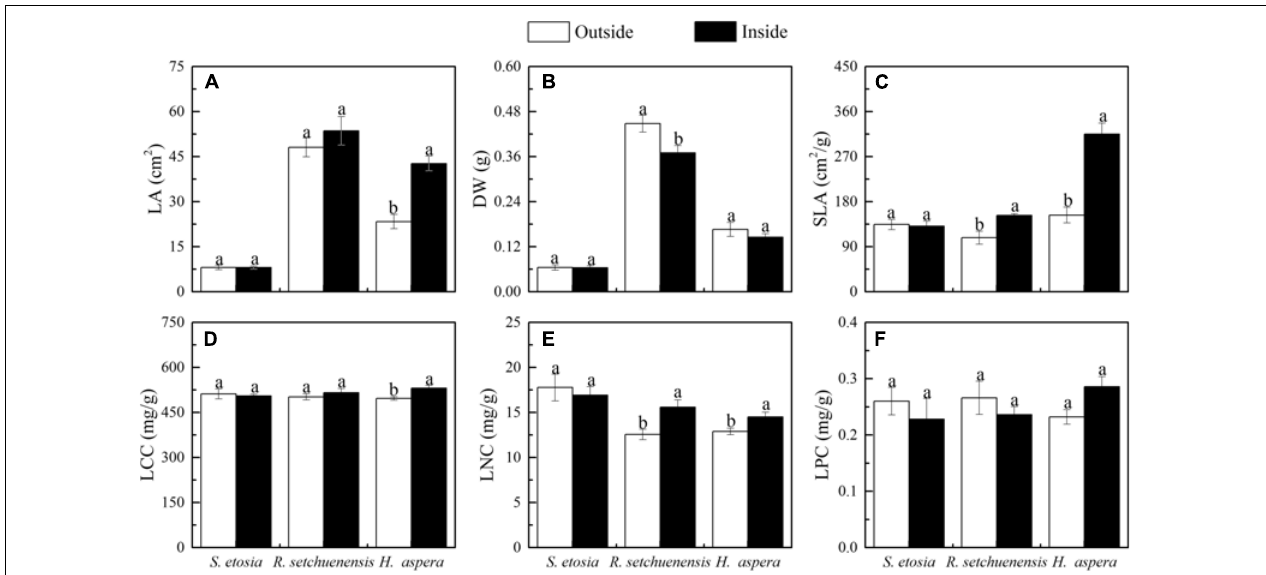
FIGURE 2 | Comparison of leaf traits outside and inside; sample numbers, N: 120 < N < 200. Different lowercases indicate significant differences of leaf traits between two habitats, and the bars represent standard error. (A) LA, leaf area; (B) DW, dry weight; (C) SLA, specific leaf area; (D) LCC, leaf carbon content; (E) LNC, leaf nitrogen content; and (F) LPC, leaf phosphorous content (the same as below). TABLE 1 | Two-way ANOVA of the effects of plant species and different habitats on leaf traits. Leaf traits df Means squares F P LA